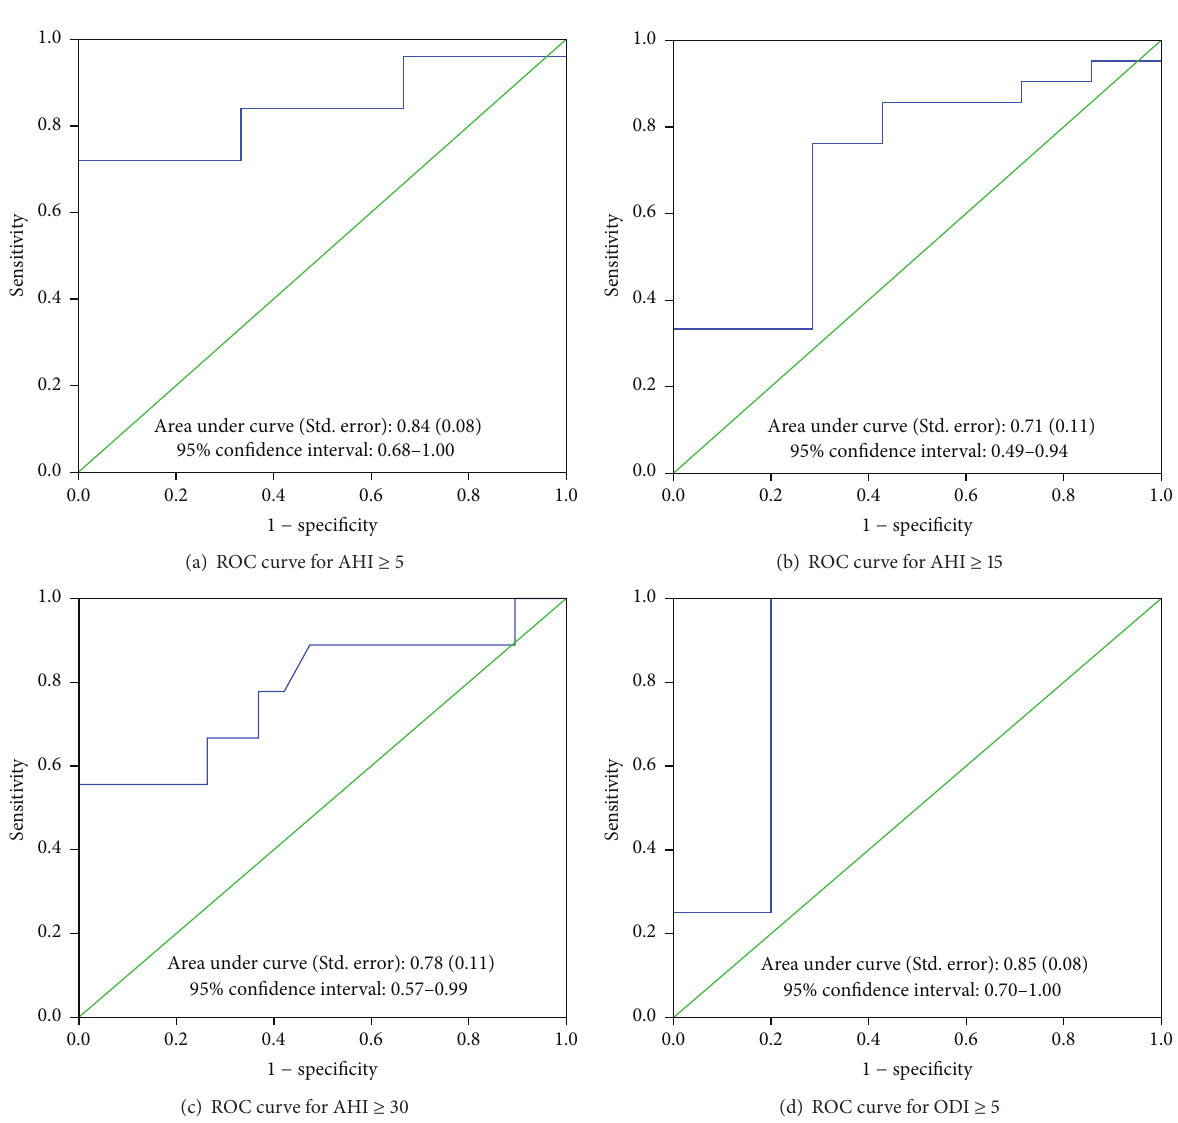
Area under curve (Std. error): 0.85 (0.08)